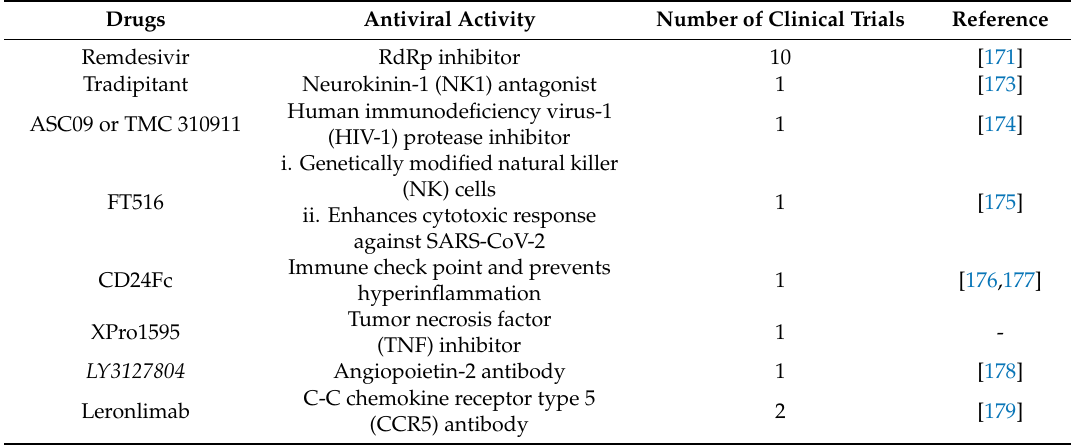
Table 2. List of investigational drugs currently being tested for